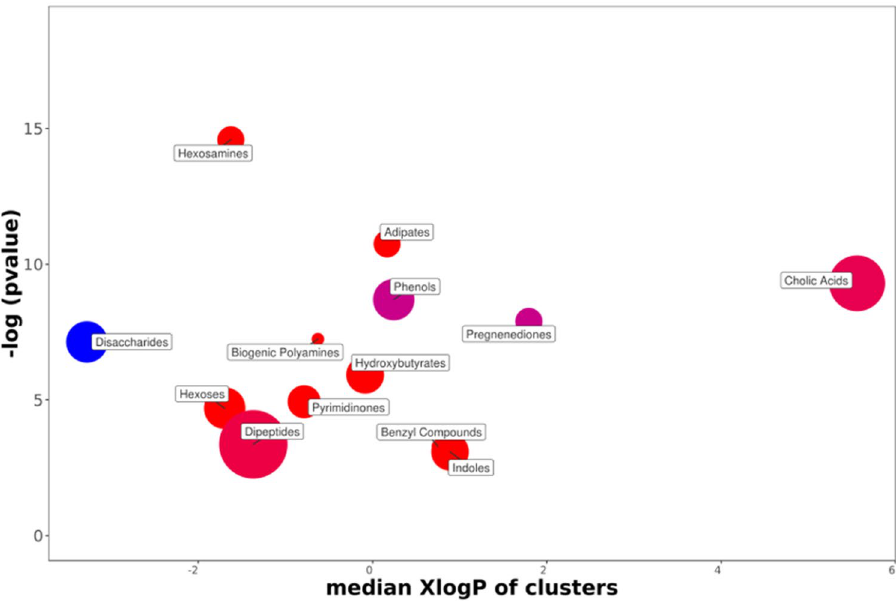
Figure 5. ChemRICH diagram according to the gender. Each disc reflects a significantly altered family of metabolites. These groups are developed from chemical similarities highlighted by a hierarchical Tanimoto map (not shown) accessible in the ChemRICH program. Enrichment p -values are given by the Kolmogorov– Smirnov test and displayed along the ordinate, with P values transformed in –log10. Disc sizes varies with the total number of metabolites. Red discs present groups of overexpressed metabolites in males while blue ones show overexpressed compounds in Females. Purple color represents both increased and decreased metabolites. For example, more adipate is found in the feces of male rats compared to females. Metabolite families are also scattered according to their increasing hydrophobicity (or decreasing hydrophilicity), from left to right along the abscissa (expressed as log P